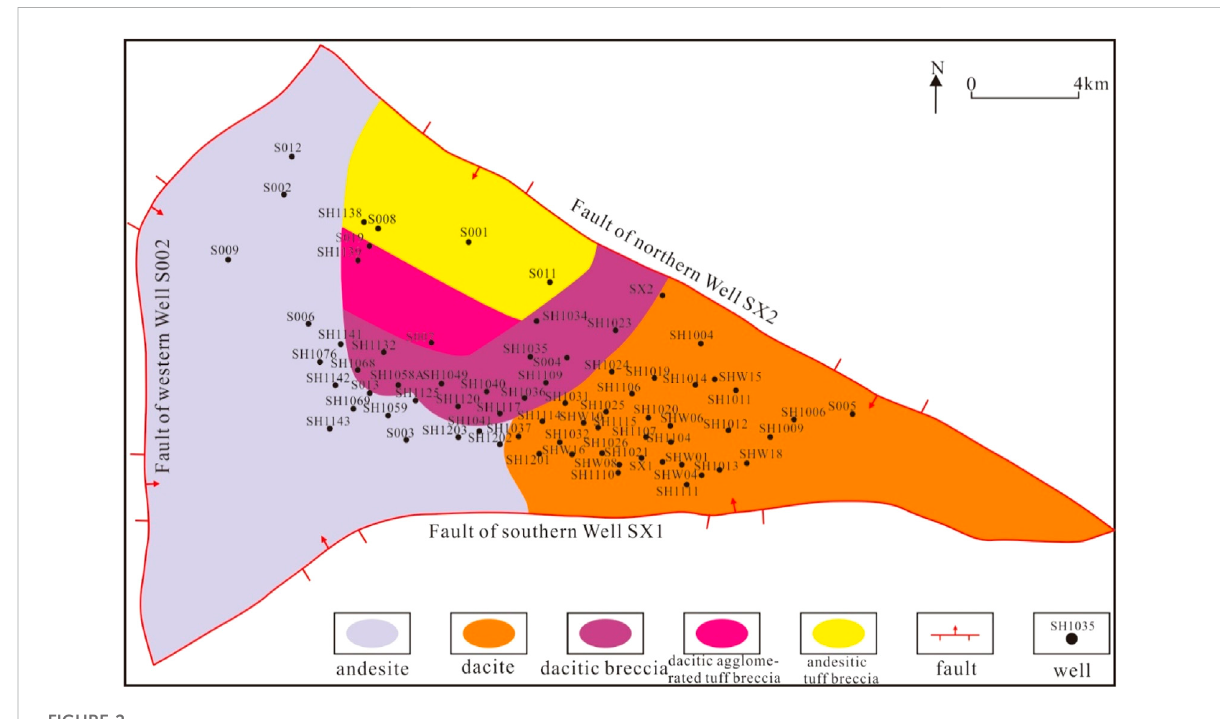
FIGURE 2 Lithology and lithofacies distribution of the Carboniferous volcanic top surface in the Shixi Oil fi